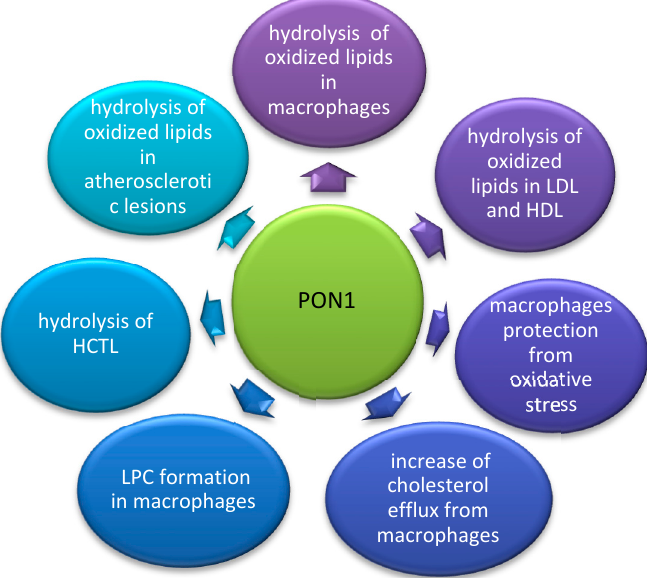
Figure 1. The antioxidative and anti-atherogenic mechanisms of PON1 enzyme. Paraoxonase 1 (PON1), lysophosphatidylcholine (LPC), homocysteine—thiolactone (HCTL).